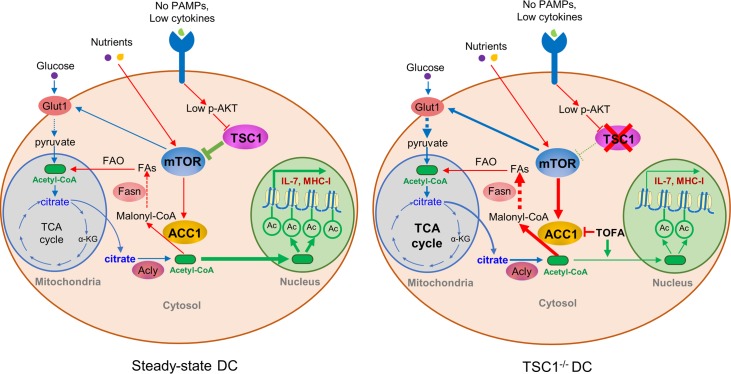
A work model illustrating the reciprocal regulation of metabolism and epigenetics in the steady-state DCs.Because of the lack of PAMPs and inflammation, steady-state DCs receive only tonic signals from the environment and thus tune down mTOR activation and fatty acid synthesis through TSC1/TSC2, ensuring adequate MHC-I and IL-7 expression. In the absence of TSC1, mTOR becomes hyperactivated, thus propelling exuberant ACC1-driven fatty acid synthesis. Consequently, only scarce acetyl-CoAs are available for histone acetylation and selective gene expression in the steady-state TSC1−/− DCs. α-KG, α-ketoglutarate; ACC1, acetyl-CoA carboxylase 1; acetyl-CoA, acetyl-coenzyme A; Acly, ATP-citrate lyase; DC, dendritic cell; FA, fatty acid; FAO, FA oxidation; Fasn, FA synthase; Glut1, glucose transporter 1; IL, interleukin; malonyl-CoA, malonyl-coenzyme A; MHC, major histocompatibility complex; mTOR, mechanistic target of rapamycin; p-AKT, phosphorylated AKT; PAMP, pathogen-associated molecule pattern; TCA, tricarboxylic acid, TSC1, tuberous sclerosis complex subunit 1; TSC2, tuberous sclerosis complex subunit 2.